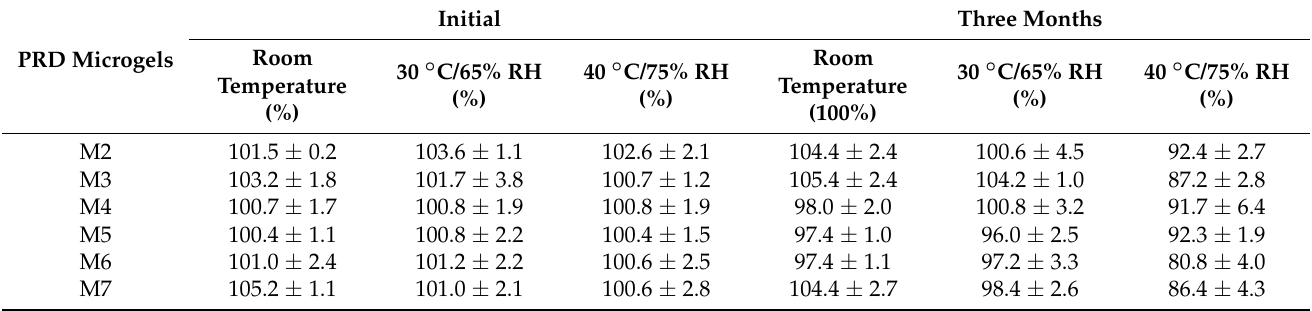
Table 11. Prednisolone (PRD) content in microgels after three months of storage at different conditions.